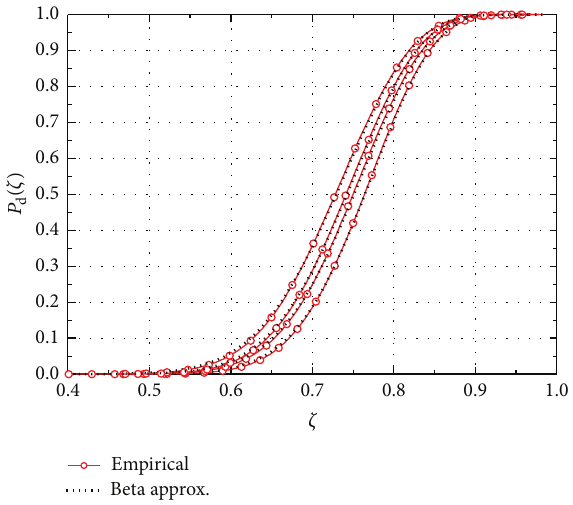
Figure 4: Variation of the detection probability of the ST with four different realizations of the channel matrix, for 𝐾 = 4, 𝑁 = 50, = − 1 dB, SNR = − 3 dB, and SNR = − 10 dB. Scenario 𝑃 = 3, SNR 1 2 3 A: fixed and normalized channel.